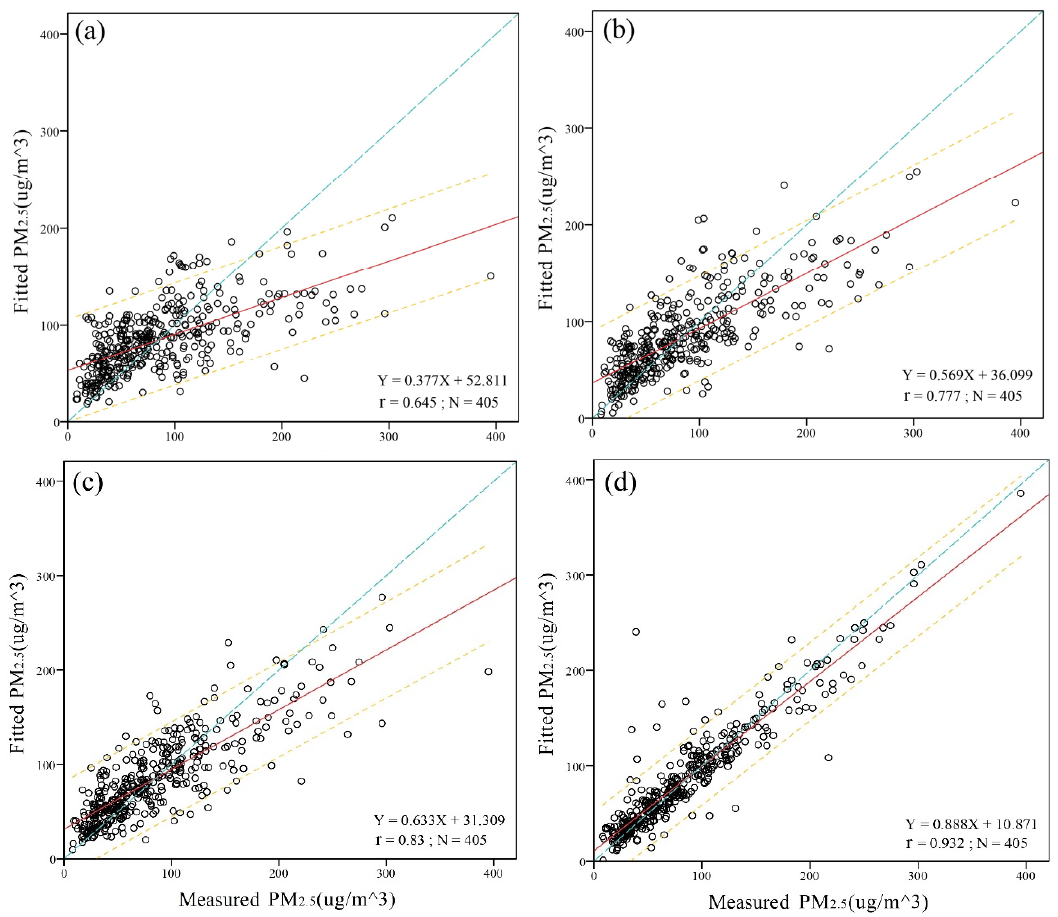
Figure 9. Scatter plots between the measured and fitted PM 2.5 concentrations for cross validation. ( a ) OLS; ( b ) GWR; ( c ) TWR and ( d ) GTWR. The short dashed ( orange ) lines, long dashed ( blue ) line, and solid ( red ) line are the 95% confidence band, 1:1 line, and regression line, respectively.